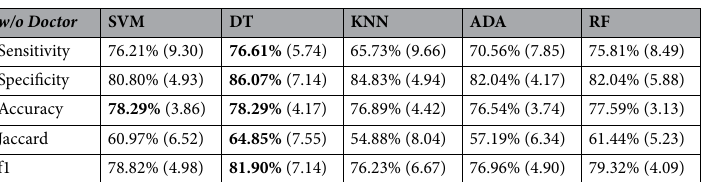
Table 7. Metrics scores achieved on selected feature subsets without expert’s verdict. STD is included in parentheses. Significant values are in bold.